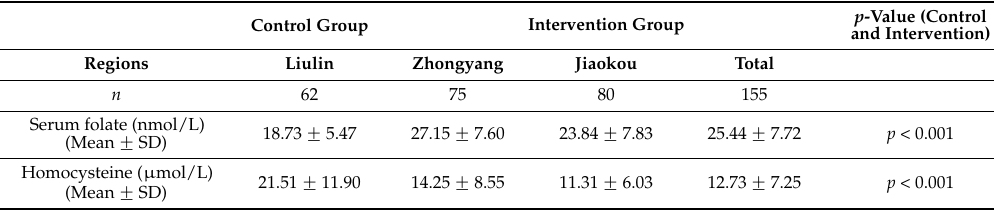
Table 3. Key bio-indicators in the control groups and intervention groups at endline.